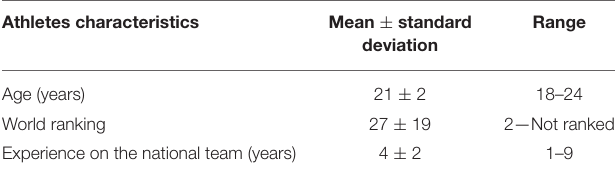
TABLE 1 | Athletes characteristics